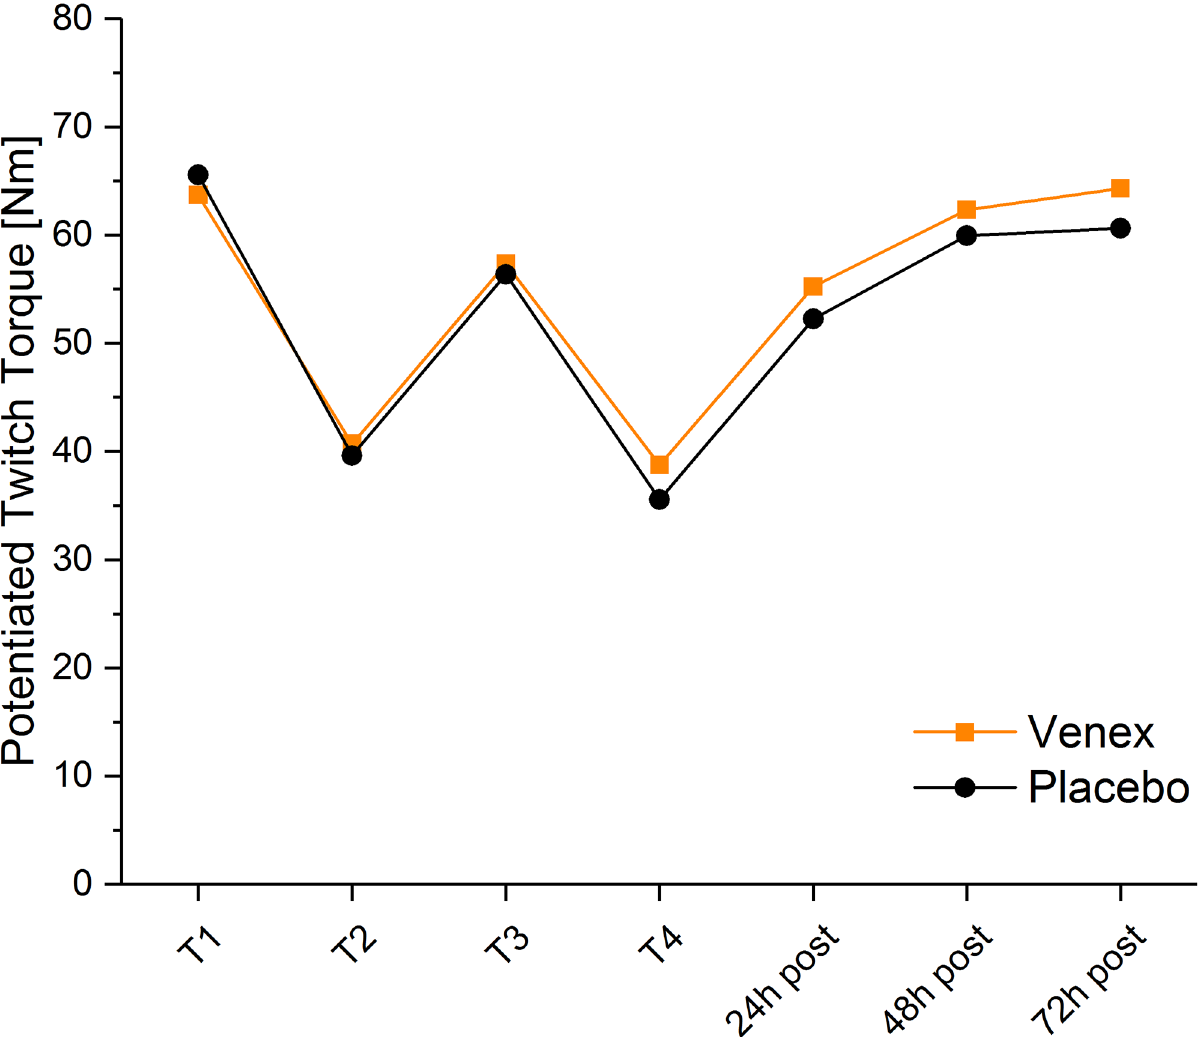
Fig 2. Potentiated twitch torque for both treatments over time. Data represent the mean ± 95% confidenceintervalsof the potentiated twitch torques.